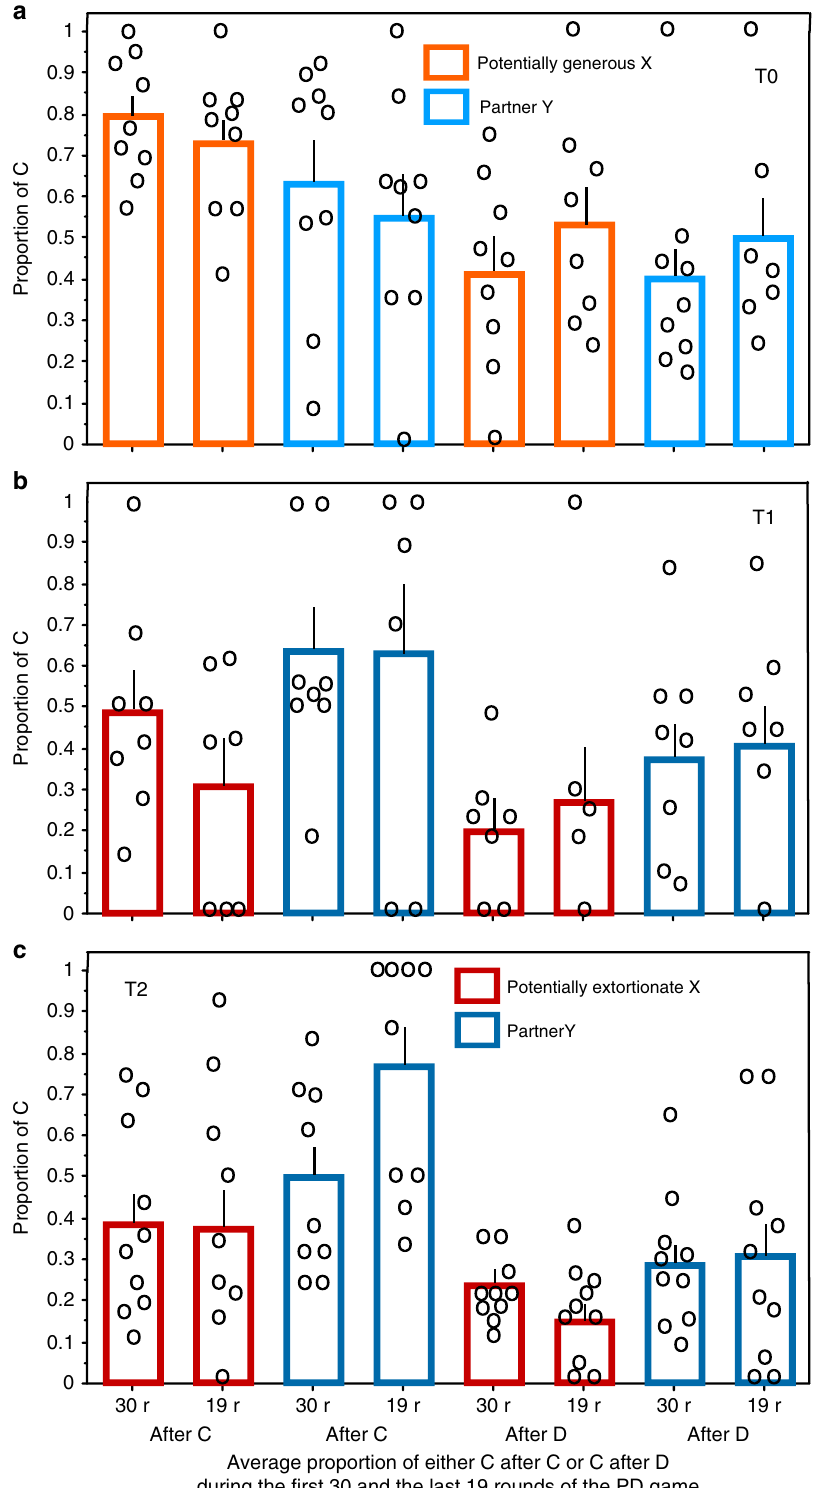
Fig. 5 Change of cooperation during the game. Average proportion ( + s.e.m.) of C ( = cooperation) decisions after either co-player ’ s C or D ( = defect) during the fi rst 30 and the last 19 rounds of the PD game. a T0 — iterated Prisoner ’ s Dilemma; C decisions of potentially generous ZD players X and their partners Y. b T1 — iterated Prisoners Dilemma with asymmetric incentive to earn 10 € bonus, if pre-determined players achieves to earn at least 10% more than partner during the whole game. C decisions of potentially extortionate ZD players X and their partners Y. c T2 — as T1 but any player of each Prisoner ’ s Dilemma pair can earn the extra bonus dependent of who achieves a competitive advantage to earn at least 10% more than partner during the whole